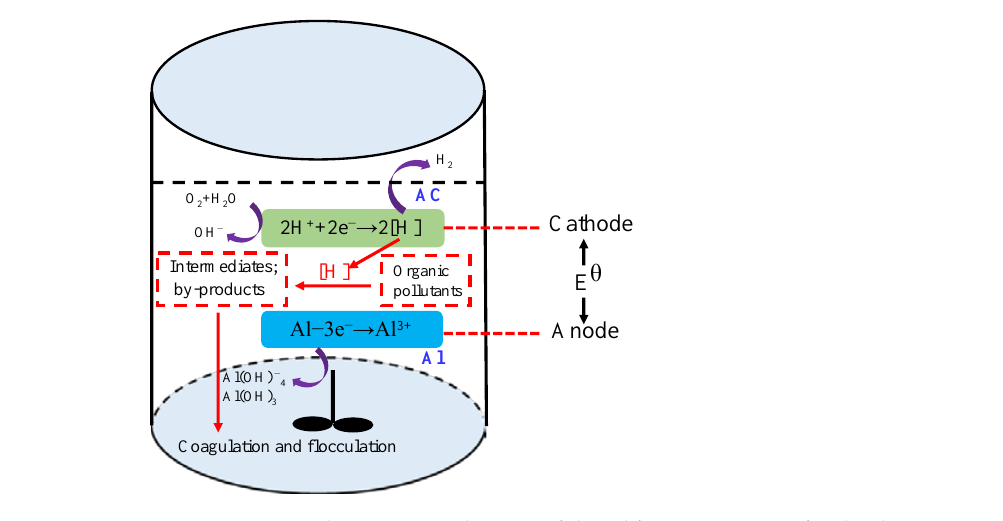
Figure 4. Proposed reaction mechanism of the Al/AC ME process for the decomposition of organic contaminants.